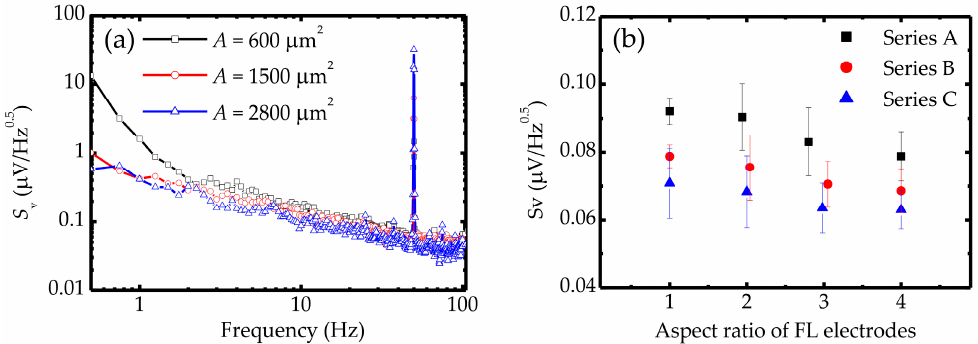
Figure 5. ( a ) Noise spectral density S v as a function of frequency for serial MTJs with various pinned junction areas at a bias voltage of 100 mV under a magnetic field of 0 Oe. ( b ) Relationships among various geometrical characteristics of serial MTJs and noise spectral density at a certain frequency (23 Hz).